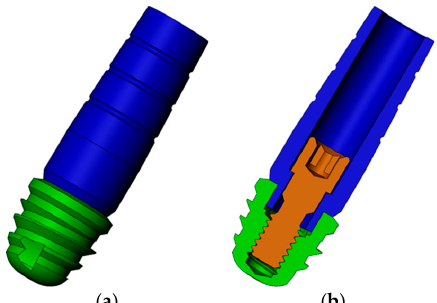
Figure 1. Three-dimensional model of internal hexagon (IH) extra-short implants: ( a ) Implant in green and abutment in blue; ( b ) transversal cut of the model to view the screw (brown).